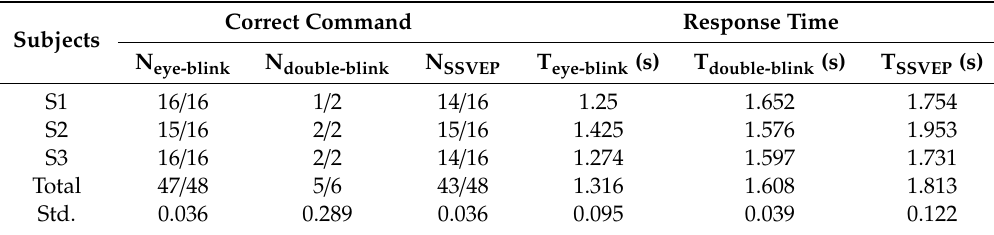
Table 2. Real-time results for three subjects controlling the virtual home automation system.